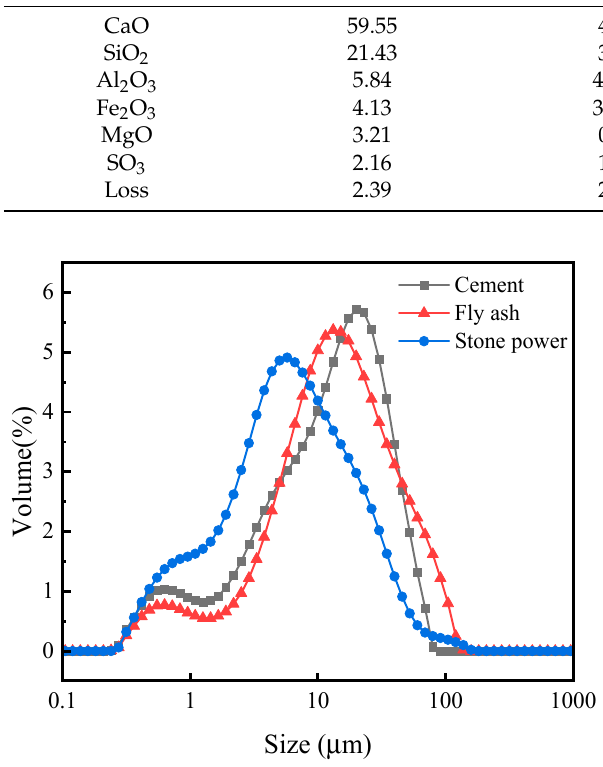
Figure 2. Particle size distributions of cement, fly ash, and stone powder. Table 3. Physical properties of fine